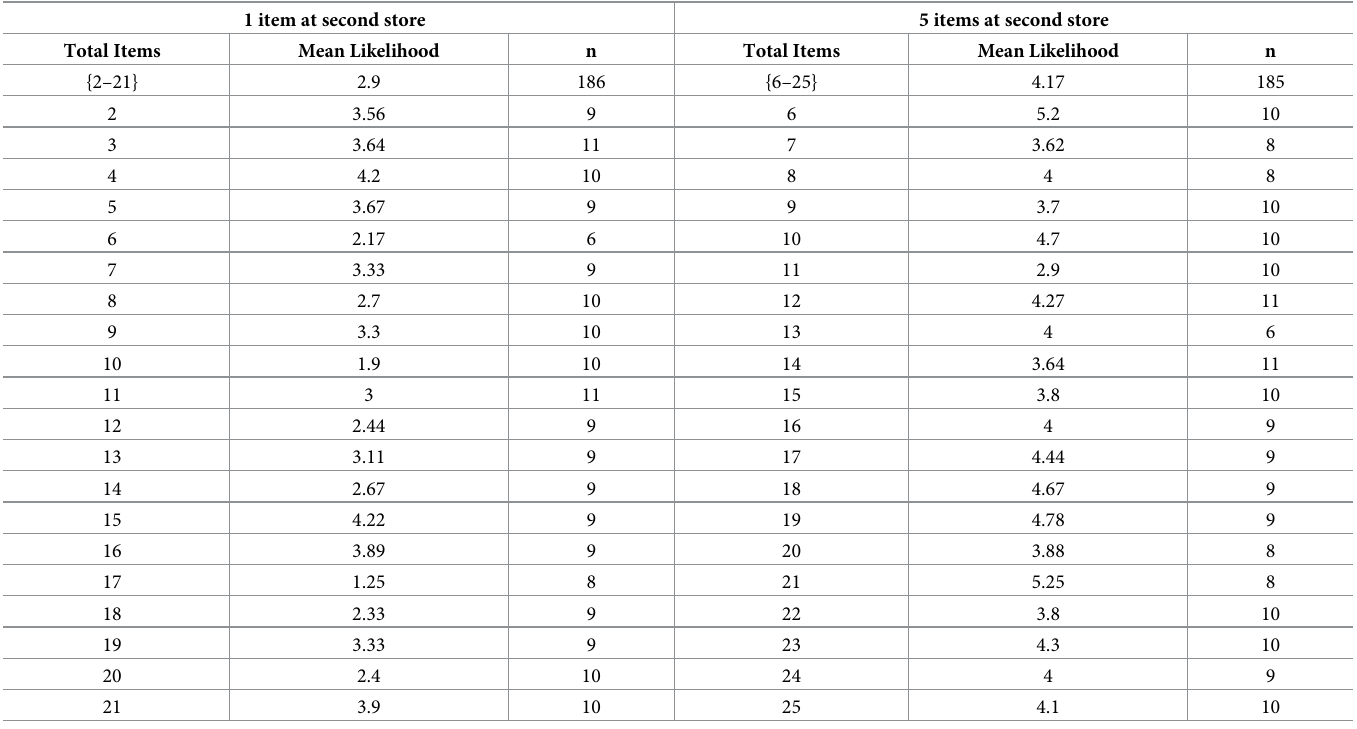
Table 9. Presentation values (n = 371) (Study 2).